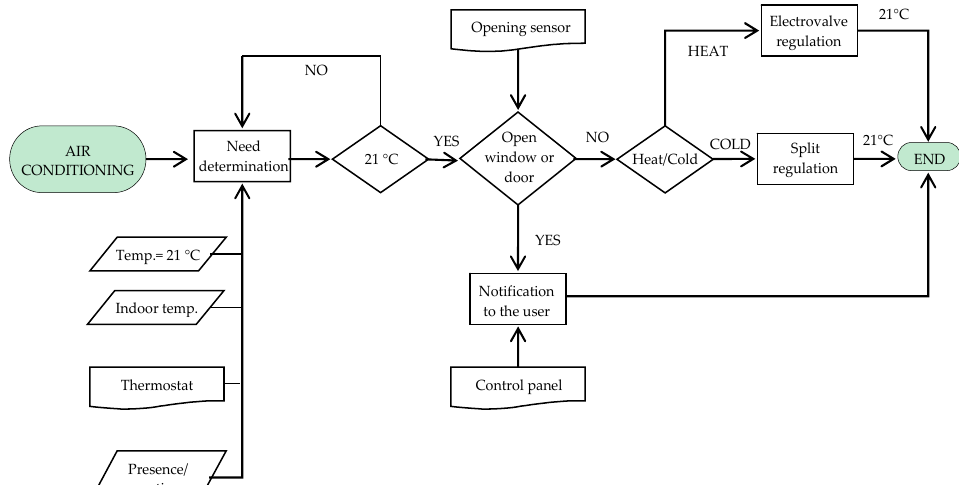
Figure 1. Air conditioning functioning flow chart.